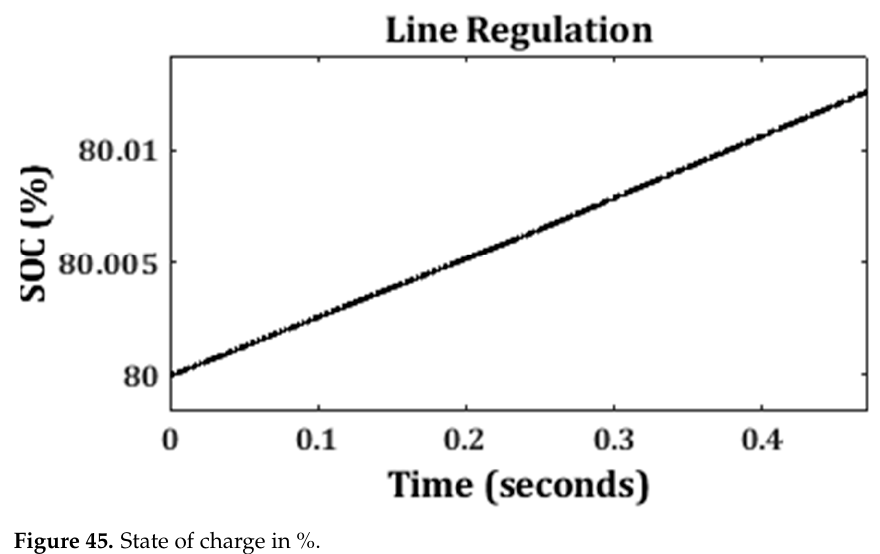
Figure 45. State of charge in %.